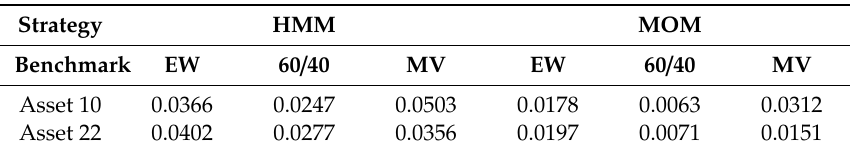
Table 8. Fama’s Net Selectivity Result.